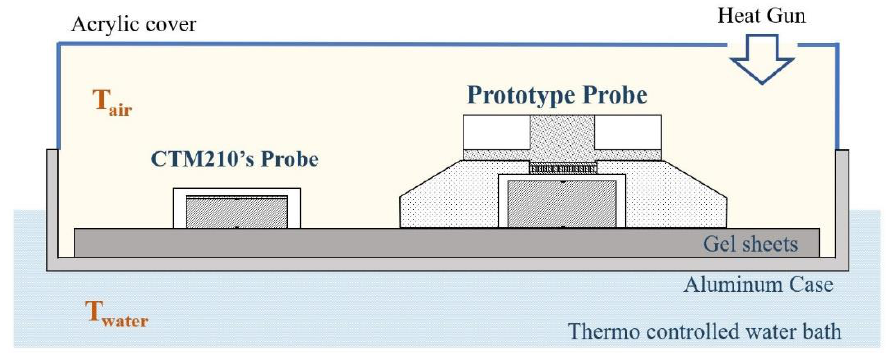
Figure 3. Cross-sectional view of the experimental setup.